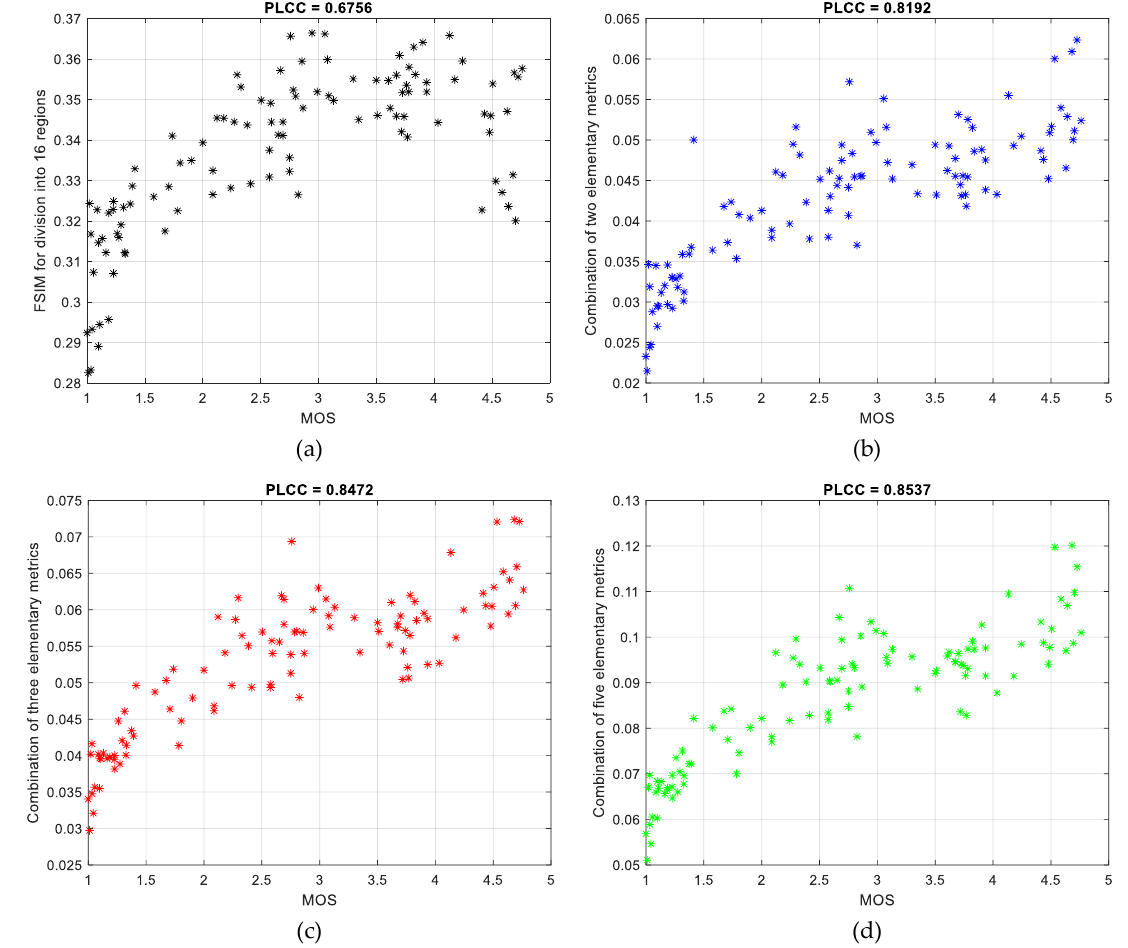
Figure 4. Scatter plots illustrating the linearity of relations between the investigated objective metrics assuming the division into 16 regions and MOS values: ( a ) for FSIM, ( b ) for the “best” combination of two metrics, ( c ) for the “best” combination of three metrics, ( d ) for the “best” combination of five